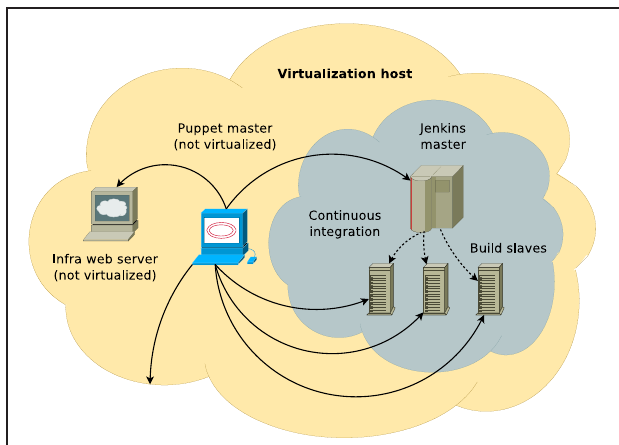
FIGURE 2 | Schematic diagram of NEST QA infrastructure. The orange cloud represents the virtualization host (Dell PowerEdge R710 server) with a number of services running directly on top of the host operating system. The gray cloud corresponds to an isolated virtual network that connects virtualized build master and build slaves. All services are managed by non-virtualized Puppet master instance. There is bi-directional communication between build master and slaves, however, neither of them communicate directly with the host (only individual services, such as Puppet master and infrastructural web server are listening to the host’s interface that is attached to the isolated virtual